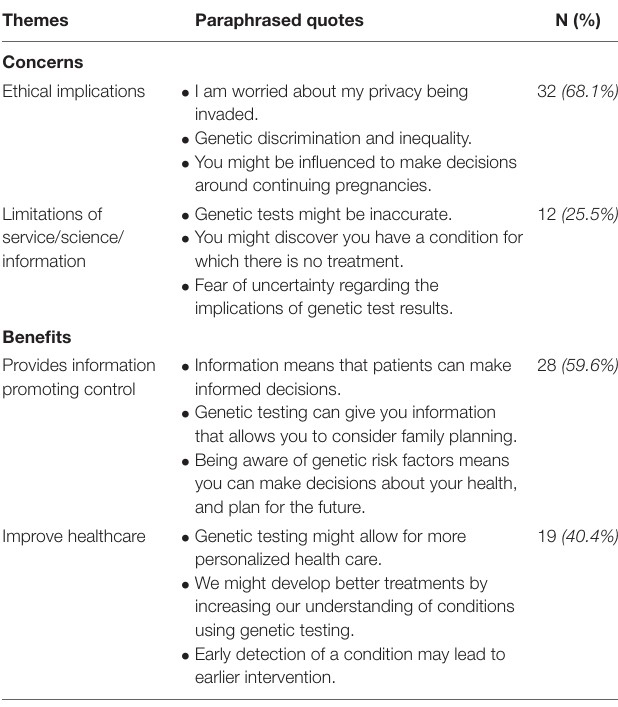
TABLE 3 | Qualitative responses in open-ended questions regarding perceived concerns and benefits of genetic testing ( n = 47). Themes Paraphrased